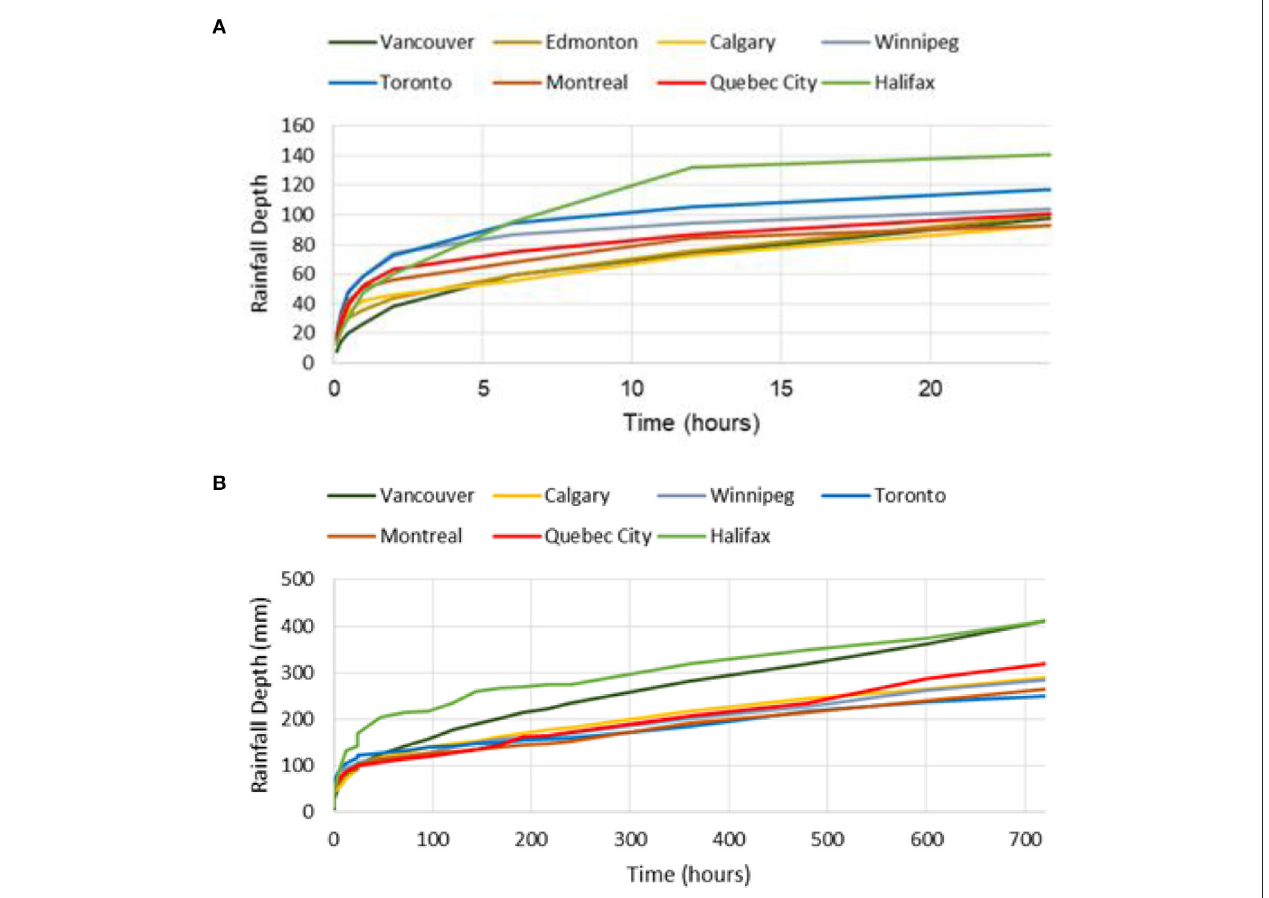
FIGURE 10 | Comparison of IDF Curve Data of 1:100 Year Event (Government of Canada, 2015). (A) Short Duration: 5min to 24hours and (B) Long Duration 5min to 30